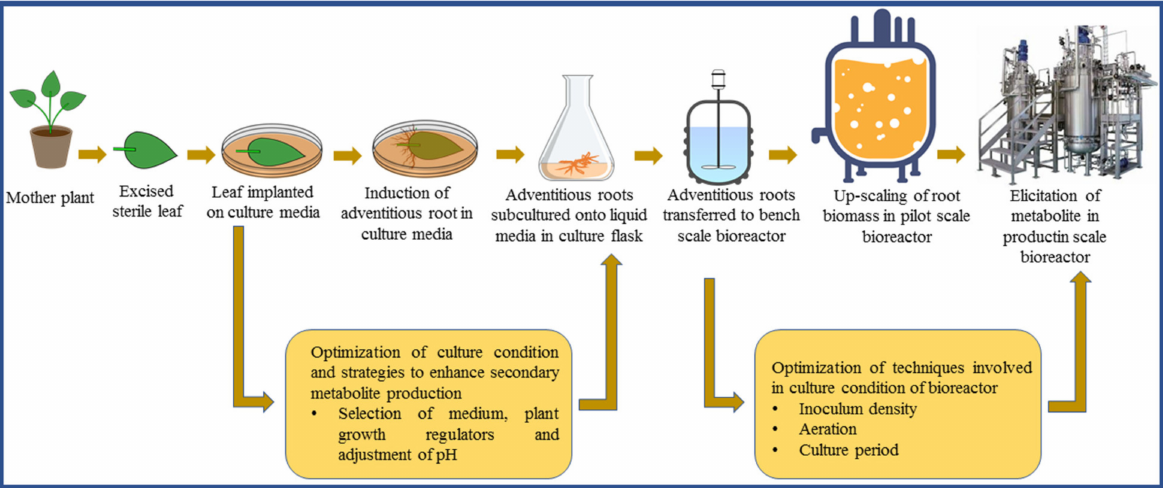
Figure 3. Illustrative representation of adventitious root-production strategy with the help of